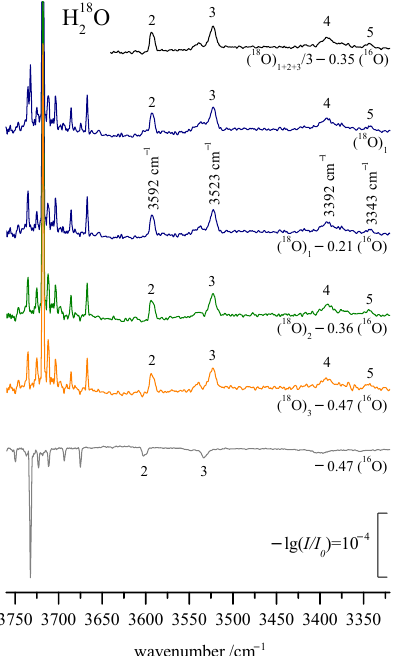
Figure 12. Clusters of H 218 O (0.75hPa) obtained in 750hPa neon expansions before (second trace from top) or after (next three traces) subtracting appropriate amounts from H 2 16 O contributions (bottom trace, 0.6hPa). The spectra from 2700 gas pulses are divided into three chronological blocks of 900 pulses ) 1,2,3 and co-averaged (top trace) after ordinary water subtraction. Cluster sizes 2,3,4,5 and band maxima in cm − 1 are provided. Isotopic dilution during this 2-day single-filling experiment can be coped with by spectral